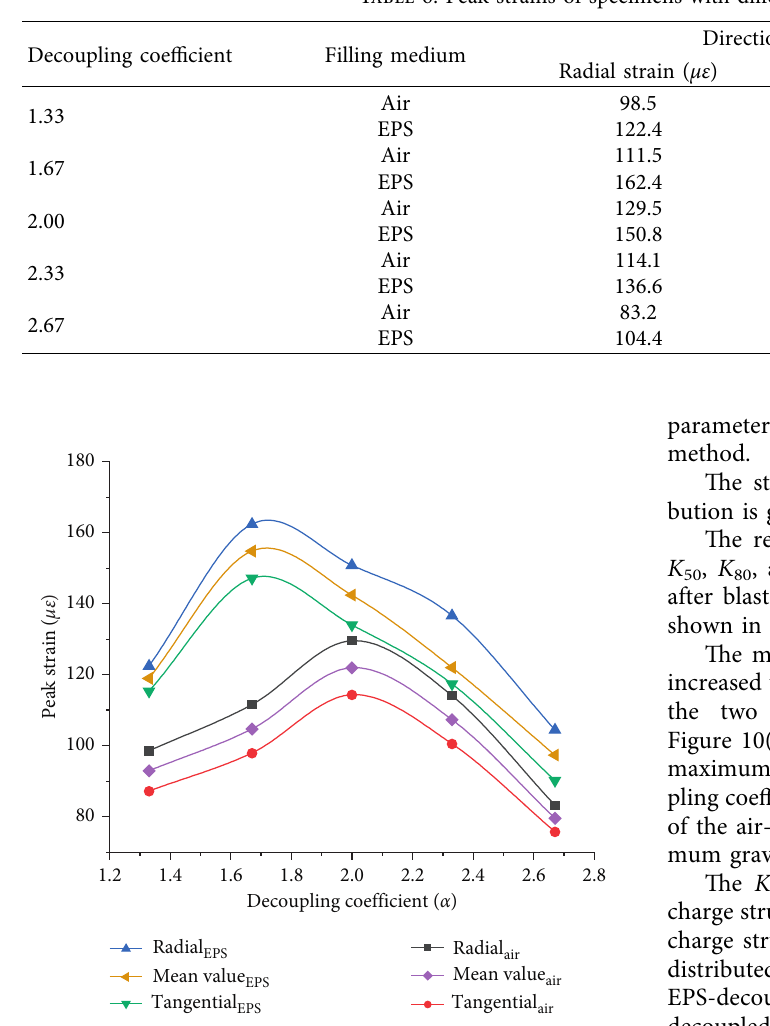
Figure 9: Peak strains of specimens with different filler Table 7 for the model specimens with different charge structures.